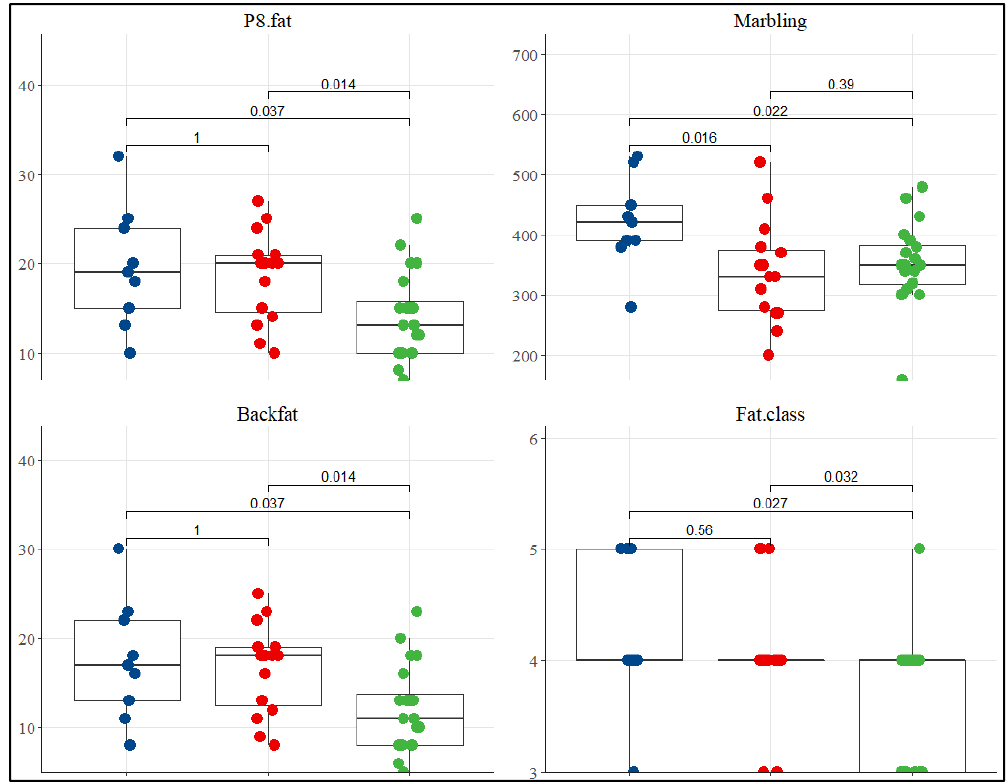
Figure 5. Multiple comparisons of P8 fat, marbling, backfat, and fat class of SCD g.21275851C>A genotypic variants CC ( ), CA ( ), and AA ( ).